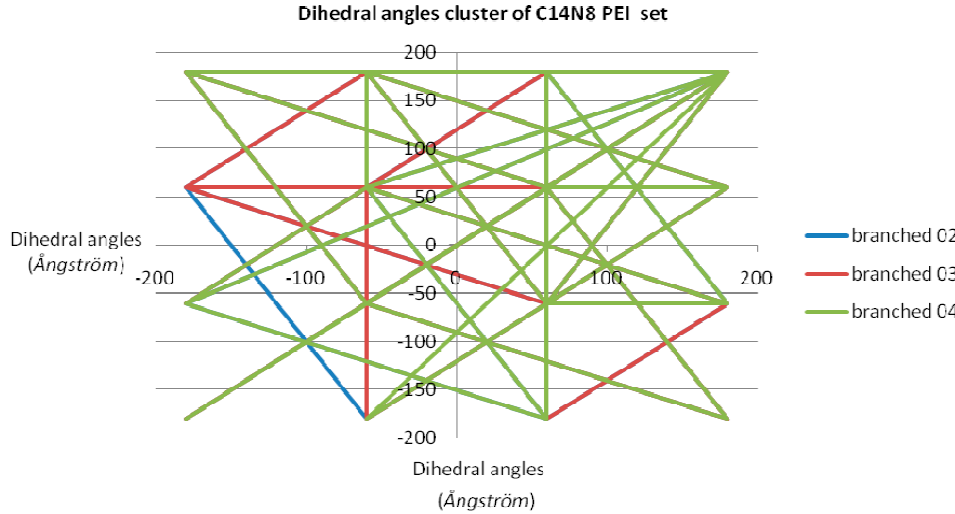
Figure 2. Dissimilarity of LPEI 01 vs . BPEIs in the C14N8 set (see additional material for the rest of the clusters obtained for C18N10 and C14N8 & C18N10).